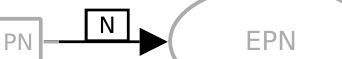
Figure 2.40 on the following page illustrates the use of consumption / production arc cardi- nality labels to represent the stoichiometry of a